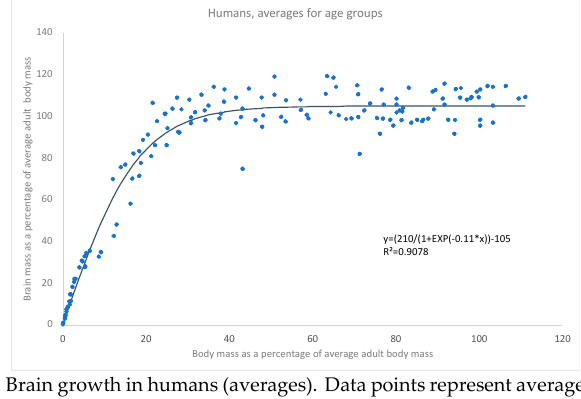
Body mass as a percentage of average adult body mass ( b ) Brain growth in humans (averages). Data points represent averages of brain and body weights for each age group. Humans, individual data